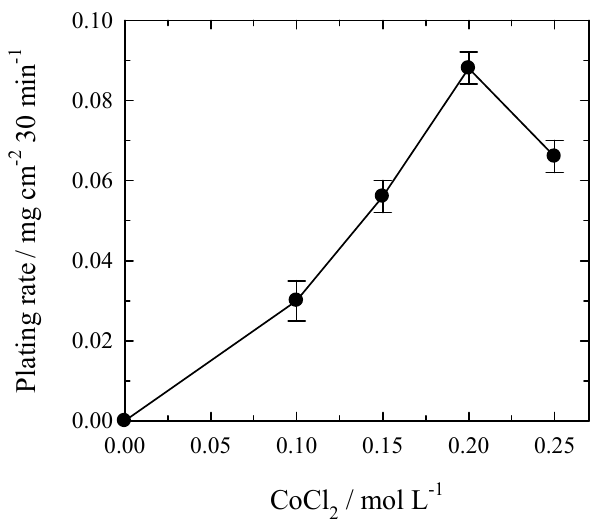
Figure 4. Effect of Co 2+ concentration on the rate of electroless Pt plating under deaeration with Ar. Solution composition (mol L − 1 ): H 2 PtCl 6 —0.004; NH 4 OH—0.4; complexing agent—0.16; HCl to pH = 7.5; t dep = 30 min; 20 ° C.